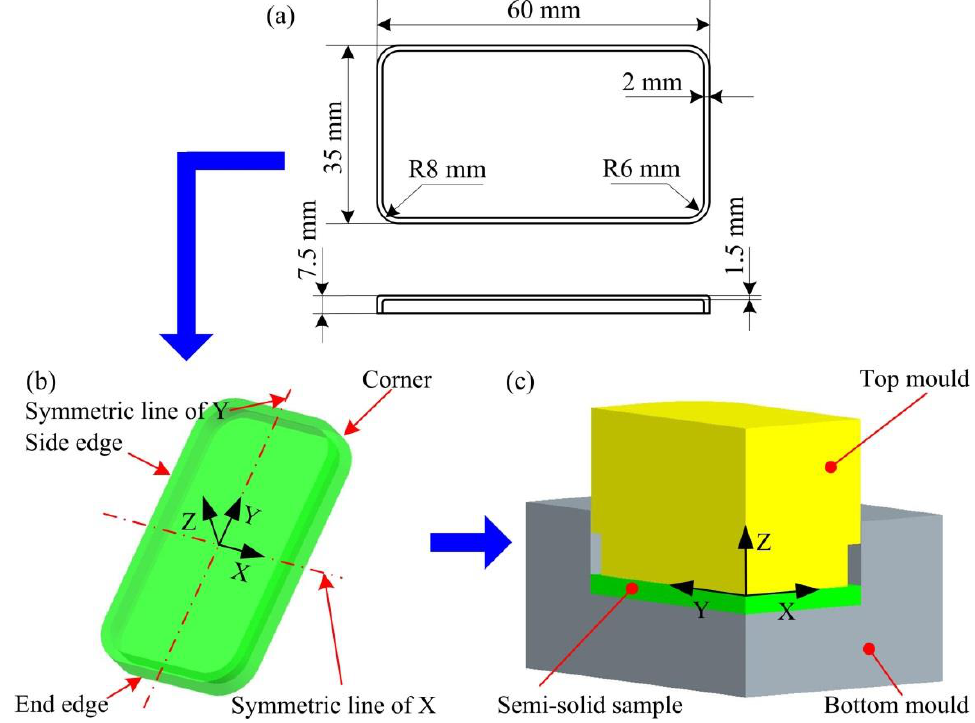
Figure 2. Schematic diagram of thixotropic extrusion forming model for the mobile phone shell: ( a ) dimensions of phone shell, ( b ) three-dimensional model, and ( c ) simulation model.